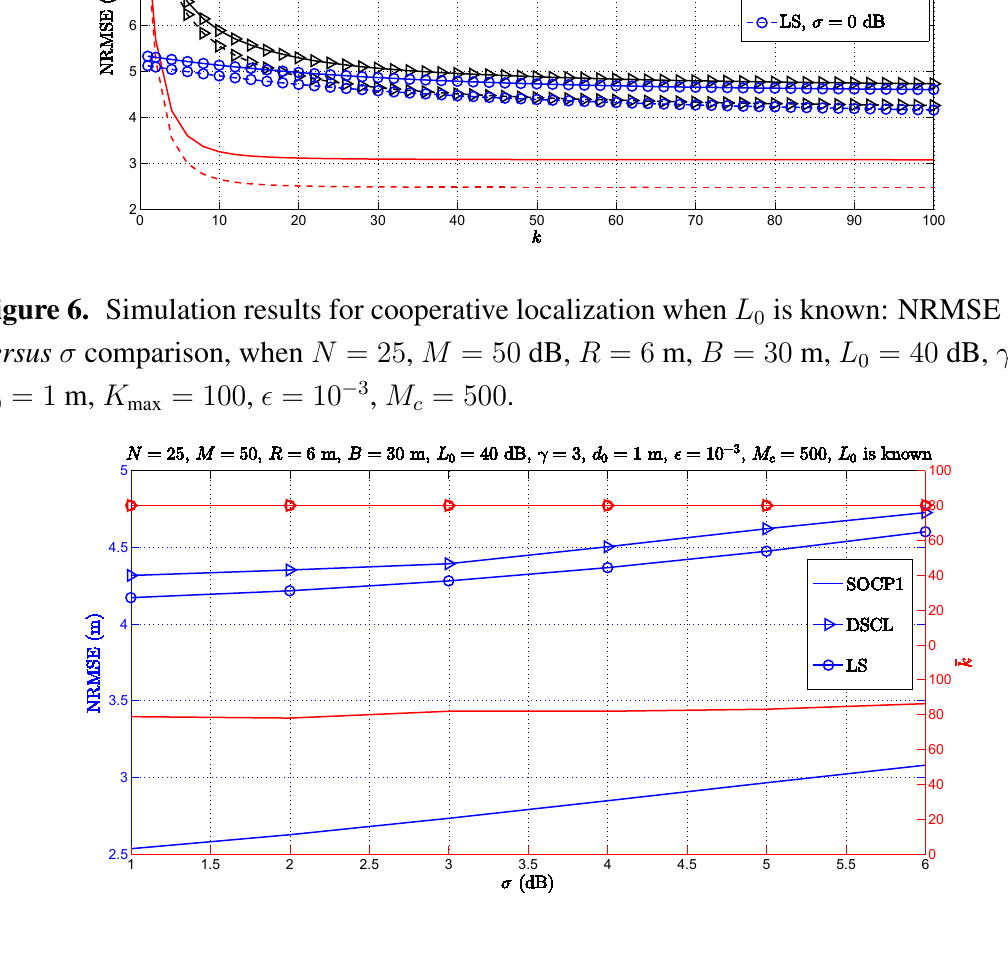
Figure 5. Simulation results for cooperative localization when L k comparison for different σ , when N = 25 , M = 50 , R = 6 m, B = 30 m, L γ = 3 , d = 1 m, K = 100 , M = 500 . 0 c max